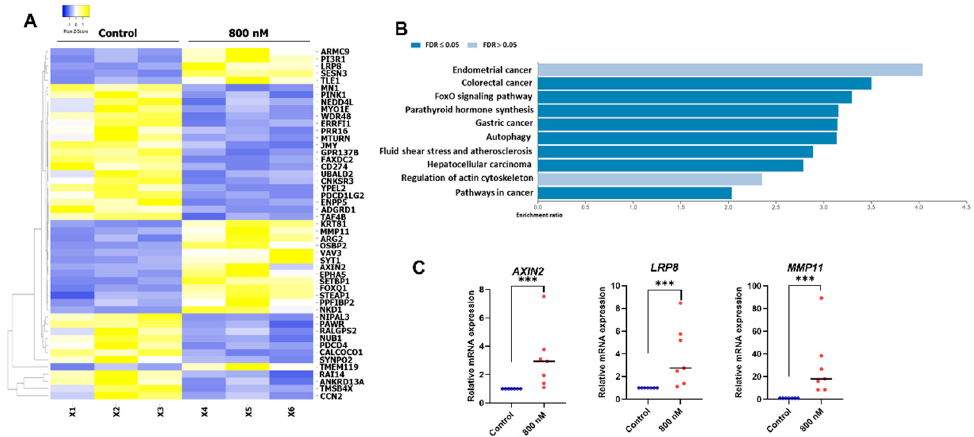
Figure 4. BIO-treated hDPSC gene expression profile. ( A ) RNA sequencing analysis was performed. Heatmap showed the top 50 significant differentially regulated genes. ( B ) KEGG pathway database enrichment analysis for the differentially expressed genes was performed by WebGestalt. ( C ) The differential gene expression of AXIN2, LRP8, and MMP11 was confirmed using a real-time polymerase chain reaction. Bars indicate a significant difference between groups (*** p < 0.001).